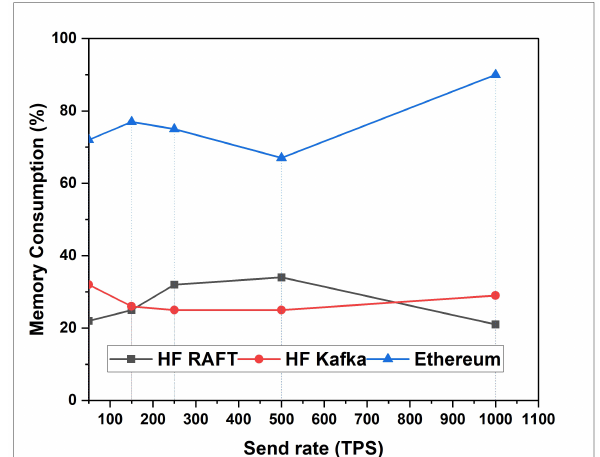
Figure 5. Memory Consumption for Transfer.